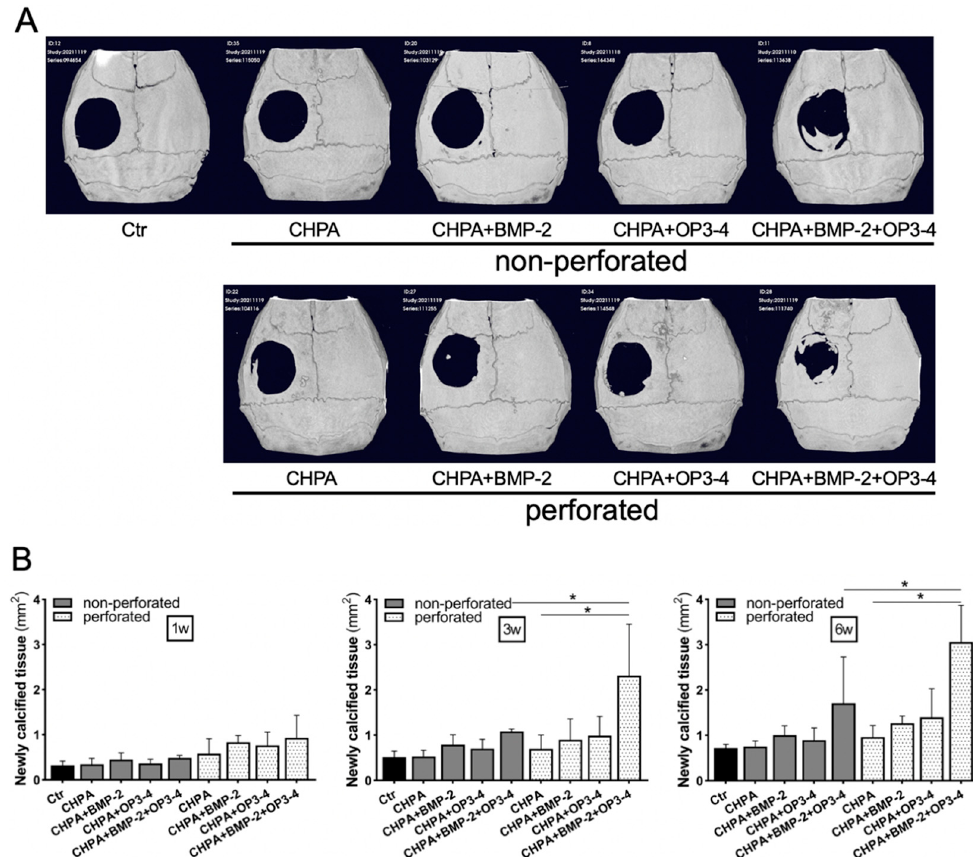
Figure 3. Perforated CHPA scaffold increased the area of newly calcified tissue in the calvarial defect model: ( A ) In vivo μ CT images of newly calcified tissue in the calvarial defect model at 6 weeks after scaffold placement. See the Figure 2 legends for group names. ( B ) The newly calcified tissue area in the calvarial defect. The newly formed calcified tissue area was quantified at 1, 3, and 6 weeks after scaffold placement. Normality was analyzed by the Shapiro–Wilk test. Comparisons between groups were performed using the Wilcoxon rank sum test. Values are expressed as the mean ± SD, * p < 0.05.